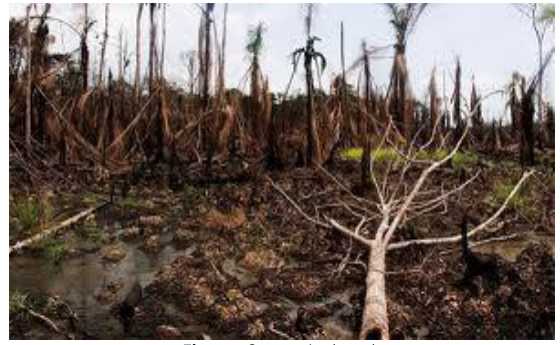
Figure 2: waste land.